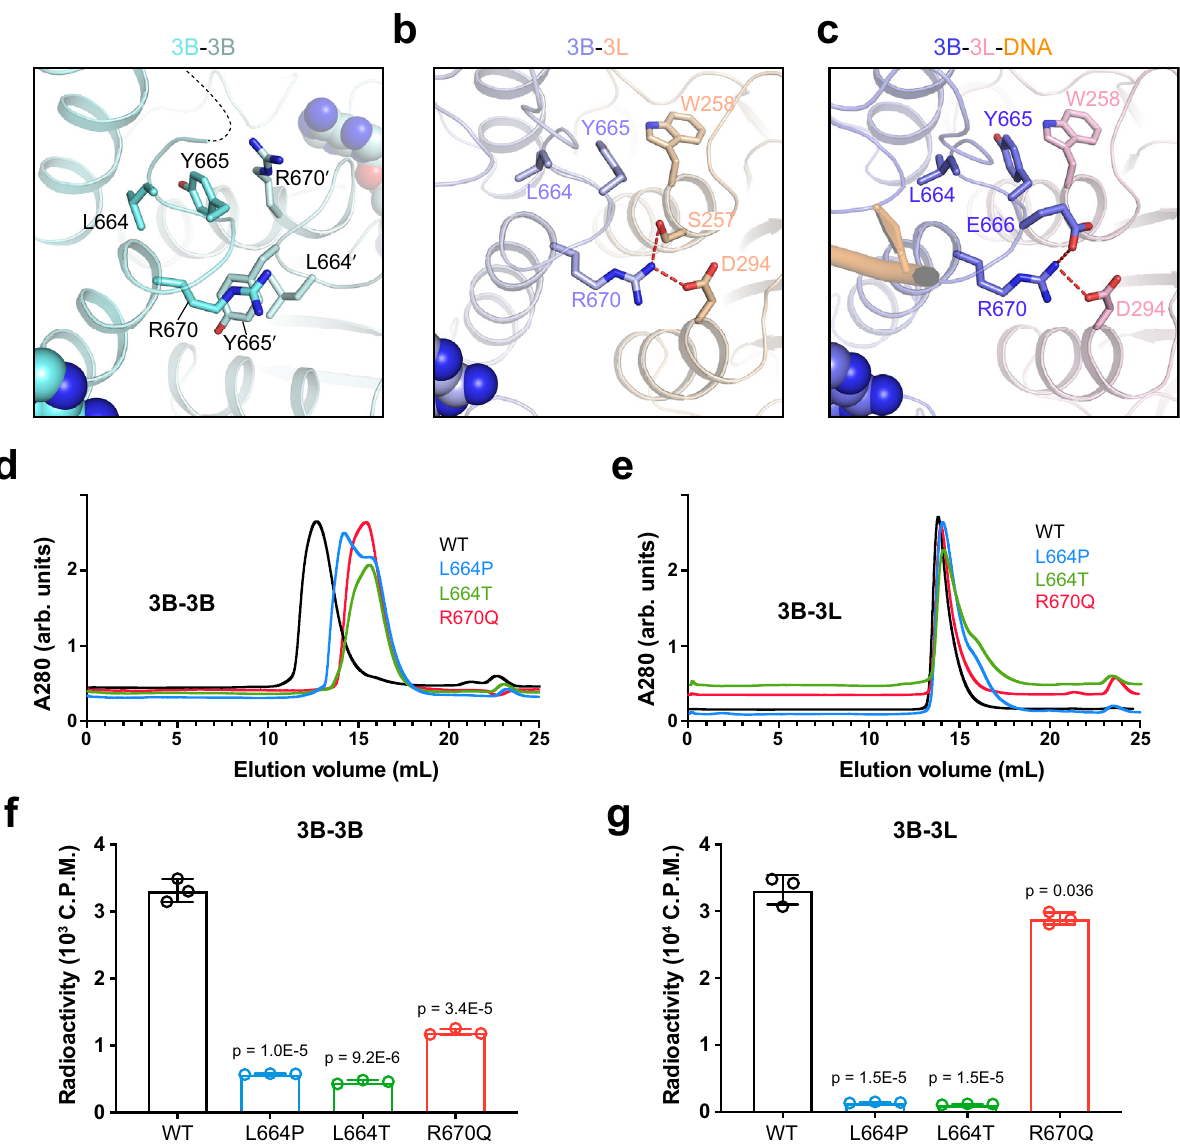
Fig. 3 Structural and biochemical analysis of the ICF mutations on the FF interface. Close-up view the ICF-associated mutation sites in the DNMT3B- DNMT3B ( a ) DNMT3B-DNMT3L ( b ) and DNMT3B-DNMT3L-DNA ( c ) complexes. The color scheme is the same as that in Fig. 2a. Size-exclusion chromatography analysis of the DNMT3B-DNMT3B ( d ) and DNMT3B-DNMT3L ( e ) complexes harboring the ICF mutations on the FF interface. The MTase domain of DNMT3B and the C-terminal domain of DNMT3L were used for the analysis. In vitro DNA methylation assays of the DNMT3B-DNMT3B ( f ) and DNMT3B-DNMT3L ( g ) complexes harboring the ICF mutations on the FF interface. Data are mean±s.d. ( n = 3 biological replicates). The two-tailed Student t -tests were performed to compare WT vs mutant. Source data are provided as a Source Data fi Supplementary Fig. 8a). Consistently, chromatin immunopreci- pitation followed by quantitative PCR (ChIP-qPCR) assay showed that WT DNMT3B bound the repeat elements at pericentric heterochromatin including major and minor satellite DNA, Intracisternal A-particle (IAP) transposons, and LINE-1 (Fig. 4d; left, red vs. black [with QKO as a background control]), in line with the previous observation that DNMT3B preserves DNA methylation in both major and minor satellites in Dnmt3a knockout mice 36 . In comparison with WT, DNMT3B carrying an ICF mutation at the FF interface (L664P or R670Q) displayed signi fi cantly reduced bindings to these heterochromatin regions (Fig. 4d, left, orange and blue vs. red), suggesting that the ICF mutations on the FF interface compromise the heterochromatin targeting of DNMT3B. In light of previous reports that the